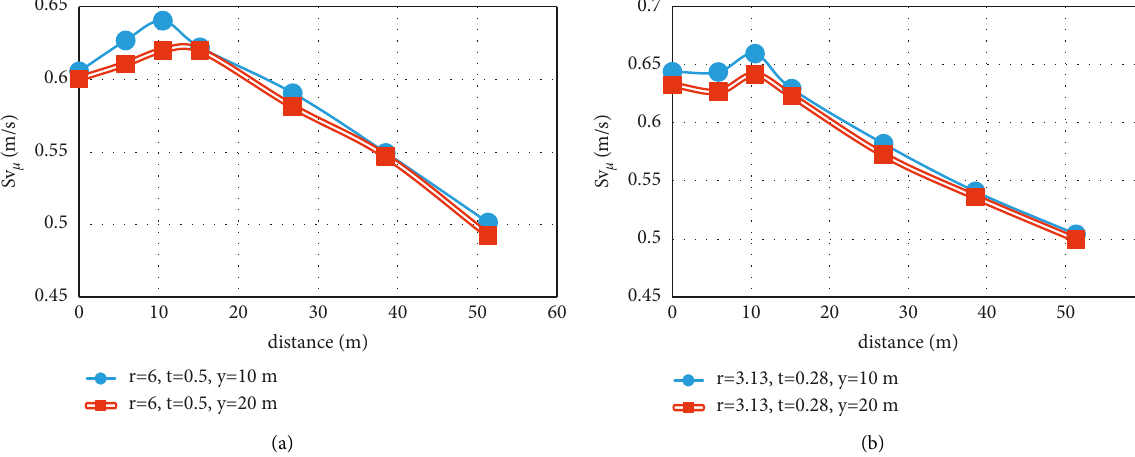
Figure 12: The effect of change in overburden depth on ground surface velocity for models (a) 23 and 24 and (b) 26 and 27 of Table 1.